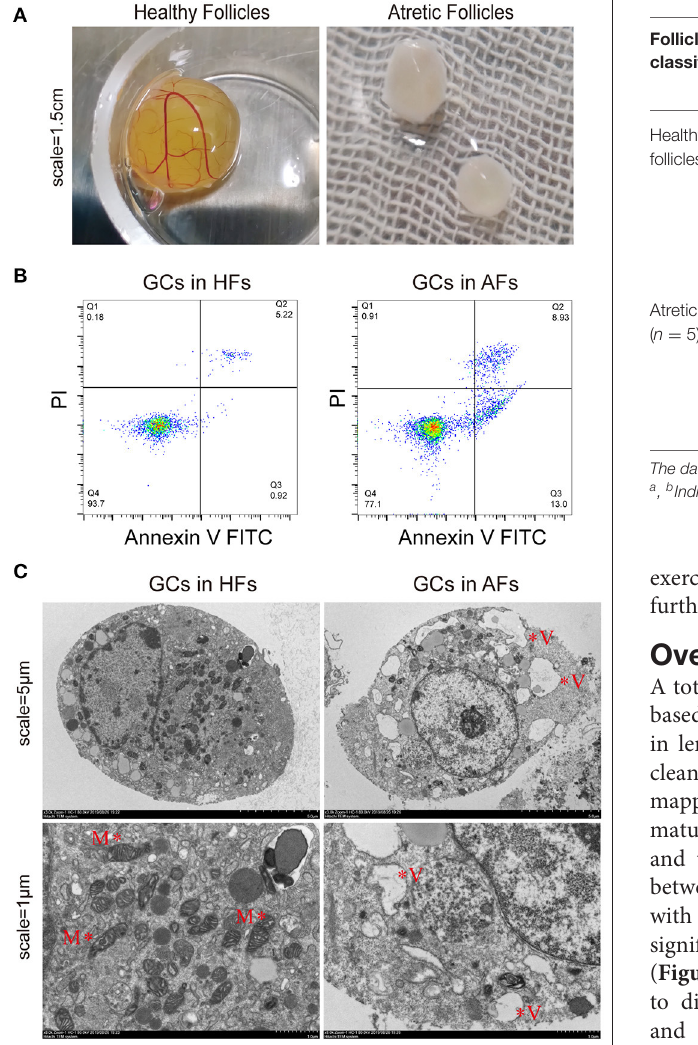
TABLE 1 | Hormone levels in follicular fluid of HFs and